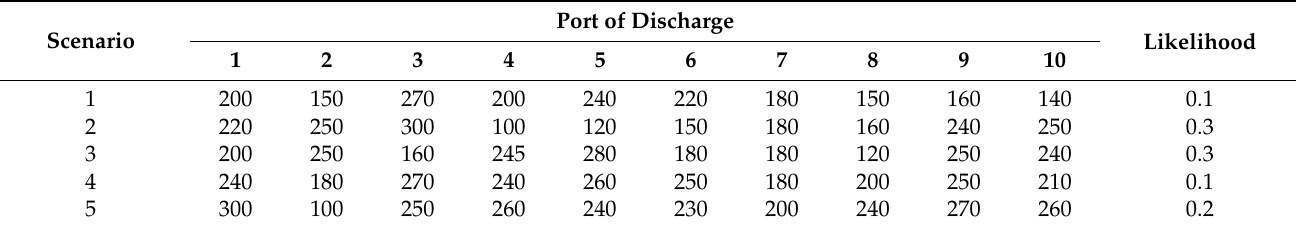
Table 1. Data for Numerical Illustration.